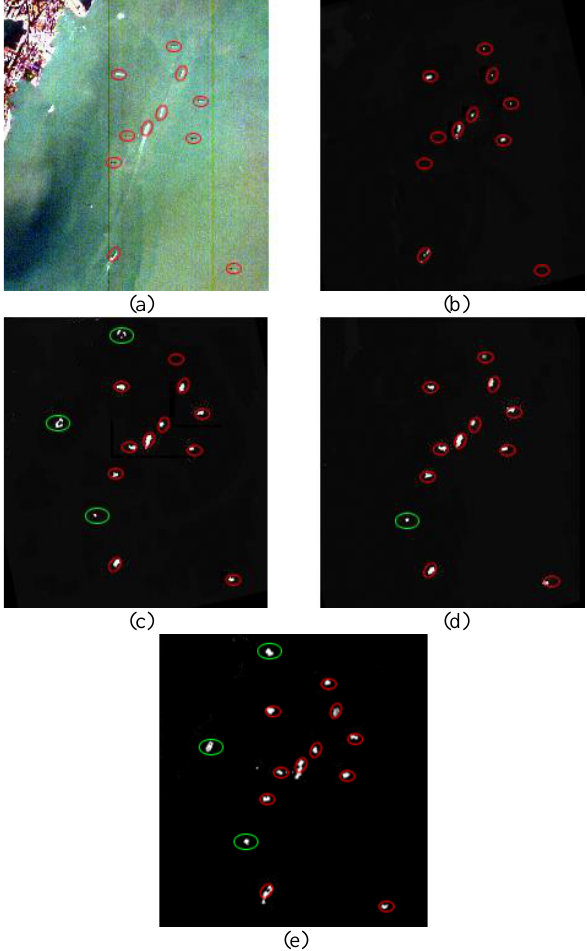
Figure 8. (a) Manually-produced reference image. (b) Ship detection result of the spectral features model. (c)